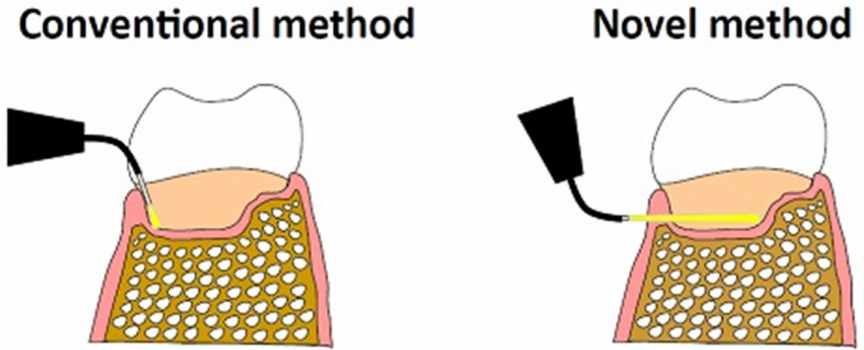
Figure 6. Advantages of a novel irradiation method for extending aPDT into inaccessible areas. On the left, the conventional irradiation method via the periodontal pocket (intra-pocket irradiation), where sufficient light cannot be delivered to inaccessible areas (e.g., furcation) due to the irradiation direction being parallel to the tooth axis. On the right, novel trans-gingival irradiation from outside the periodontal pocket (external irradiation), where light passing through the gingiva can penetrate deep into inaccessible areas. Modified with permission from Sasaki et al.